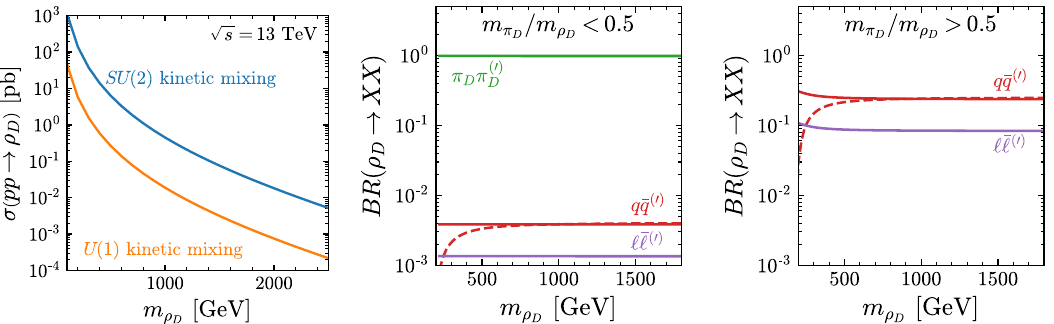
Figure 1 . The left panel shows the production cross section at √ s = 13 TeV for the dark vec- tor mesons. The blue and orange lines depict whether the vector mesons are SU(2) symmetric and kinetically mix with the appropriate standard model gauge bosons. The middle and right panels show the subsequent branching ratio for the ρ . The red lines denote decays to quark anti-quark pairs, and the dashed line can decay to the π D indicates the top quark. The purple lines show leptonic